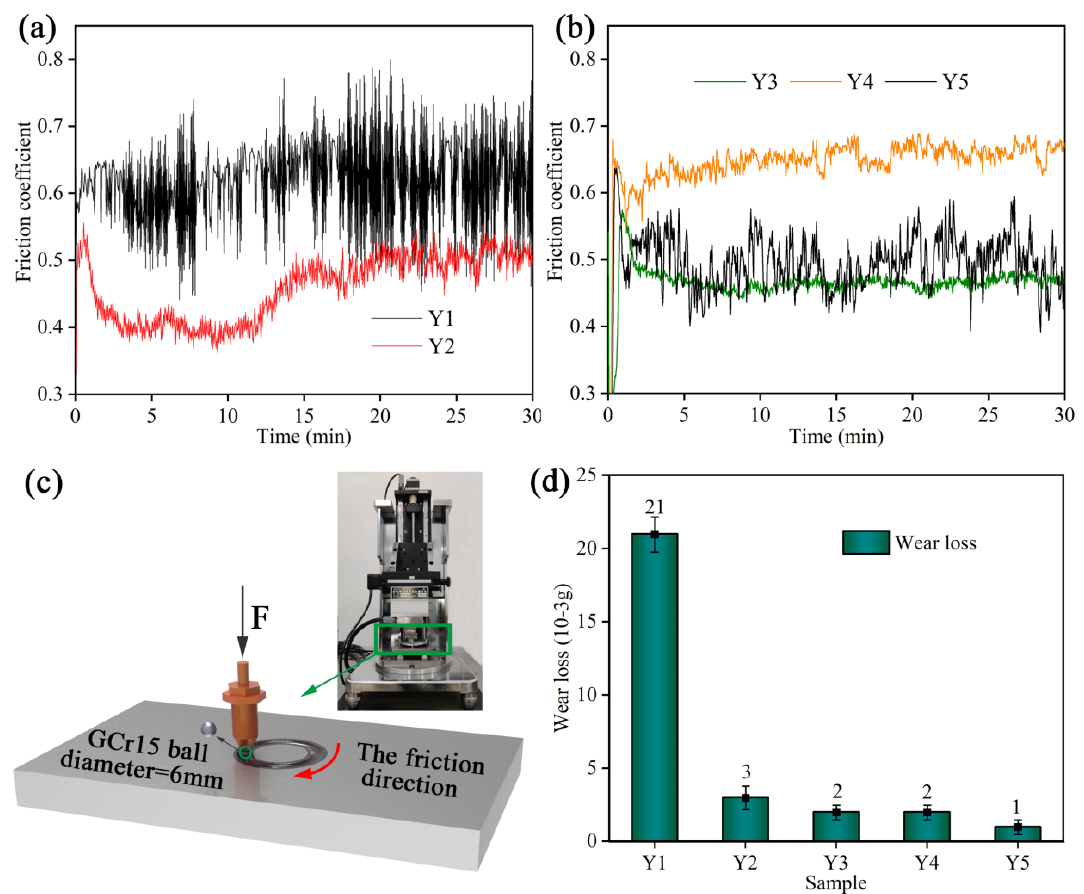
Figure 3. The curve of friction coefficient for ( a ) M1 and M2, ( b ) M3, M4, M5 and M6. ( c ) Wear schematic. ( d ) Wear loss analysis.